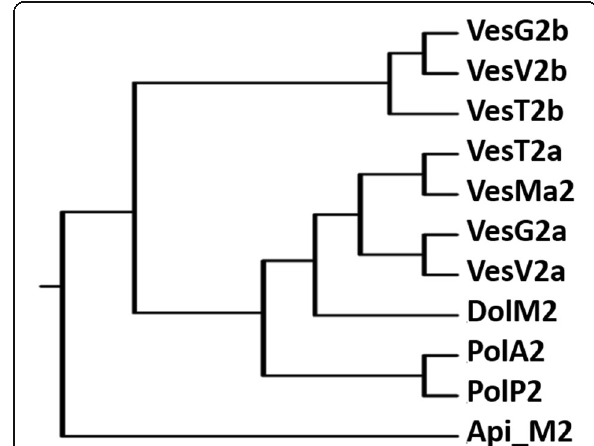
Fig. 5 The phylogenic tree of HAases from insect venoms